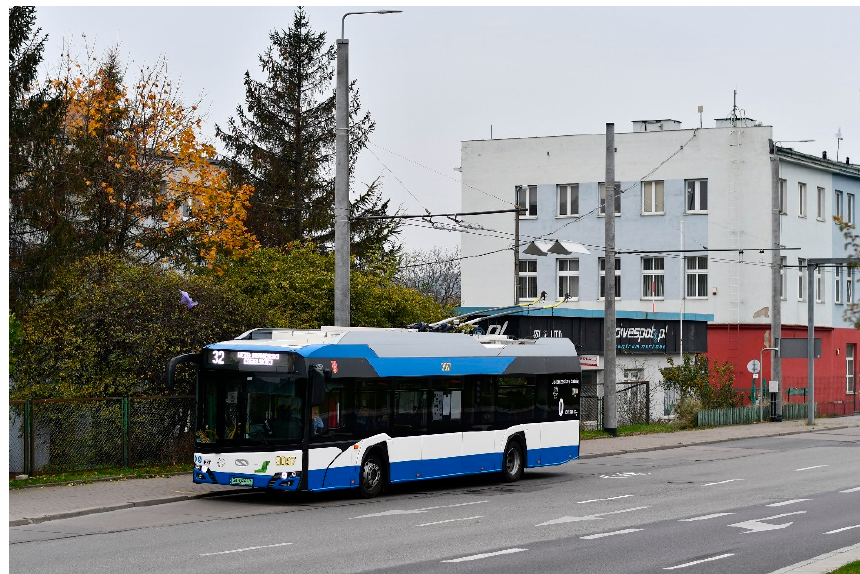
Figure 3. The process of automatic connection to the overhead line of a Solaris Trollino 12 M trolleybus on line 32 (photo taken by K. Grzonka).